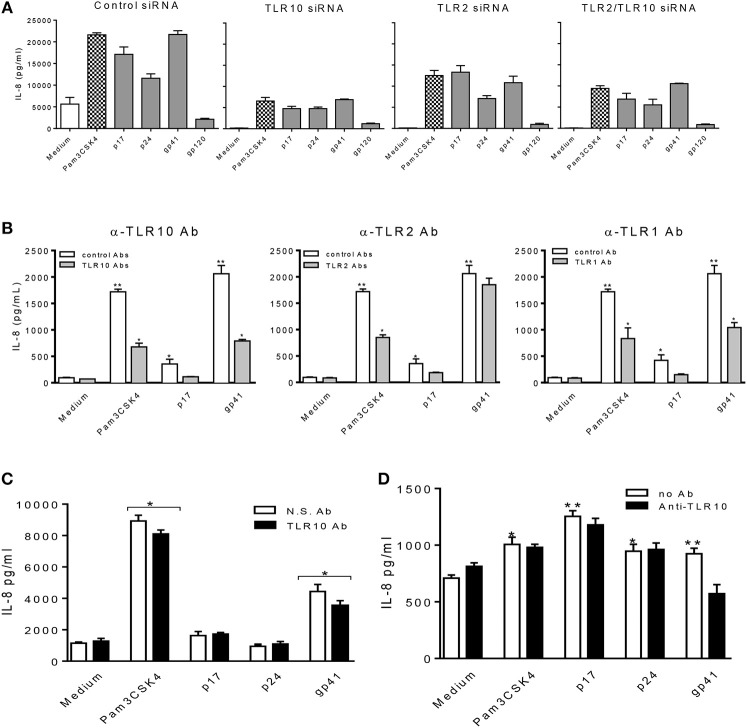
HIV-1 proteins, p17 and gp41 elicit cellular responses through sensing TLR10, TLR2, and TLR1. IL-8 production stimulated by Pam3CSK4, p17, p24, and gp41 was greatly suppressed in THP-1 cells knocked-down of TLR10 with specific siRNA (A) and THP-1 cells neutralized with anti-TLR10 antibody (B). (C) IL-8 stimulated by Pam3CSK4 and gp41 was reduced in MCF-10A cells neutralized with an anti-TLR10 antibody. (D) Primary BM cells displayed a significant decrease in IL-8 production induced by HIV-1 gp41 following neutralization with an anti-TLR10 antibody. Data set is representative of three different experiments completed in triplicate. Statistic marks: *p < 0.05; **p < 0.01 for Mann Whitney t-tests, with each group compared to the medium treated group (Medium).